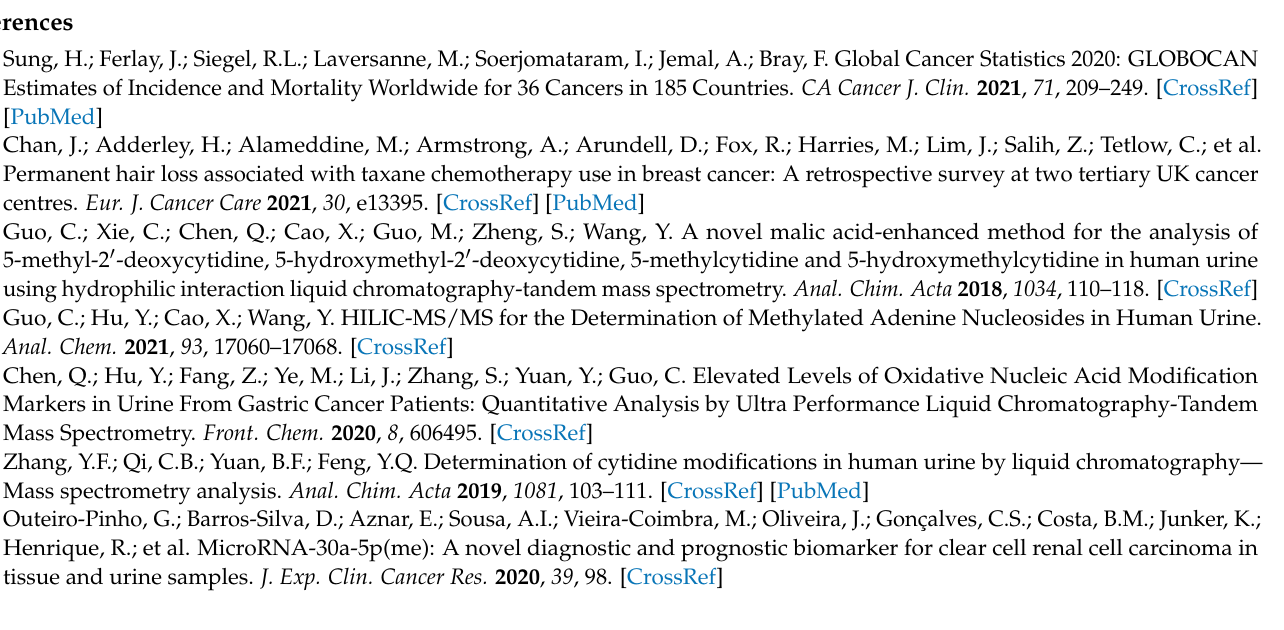
Table S2. Limits of detection (LODs) and limits of quantification (LOQs) of A m , m 6 A, m 1 A, m 6 A m , G m , m 1 G, C m , m 5 C, U m and m 5 U in HILIC-MS/MS when malic acid was used or not. Table S3: The intra- and inter-day accuracy and precision for the determination of A m , m 6 A, m 1 A, m 6 A m , G m , m 1 G, C m , m 5 C, U m and m 5 U by HILIC-MS/MS method. Table S4: Recoveries of the HILIC-MS/MS method obtained at three different spiking levels. Table S5: Stability of analytes during 72 h at room temperature, 4 ◦ C and − 20 ◦ C. Table S6: The normalized levels of methylated nucleosides in the urine samples from NC, EBC and LABC patients. Table S7: The concentrations of methylated nucleosides and creatinine in the urine samples from all participants. Table S8: The cutoff values of A m , m 6 A, m 1 A, m 6 A m , G m , m 1 G, C m and m 5 C. Table S9: Univariate and multivariate analysis of risk factors